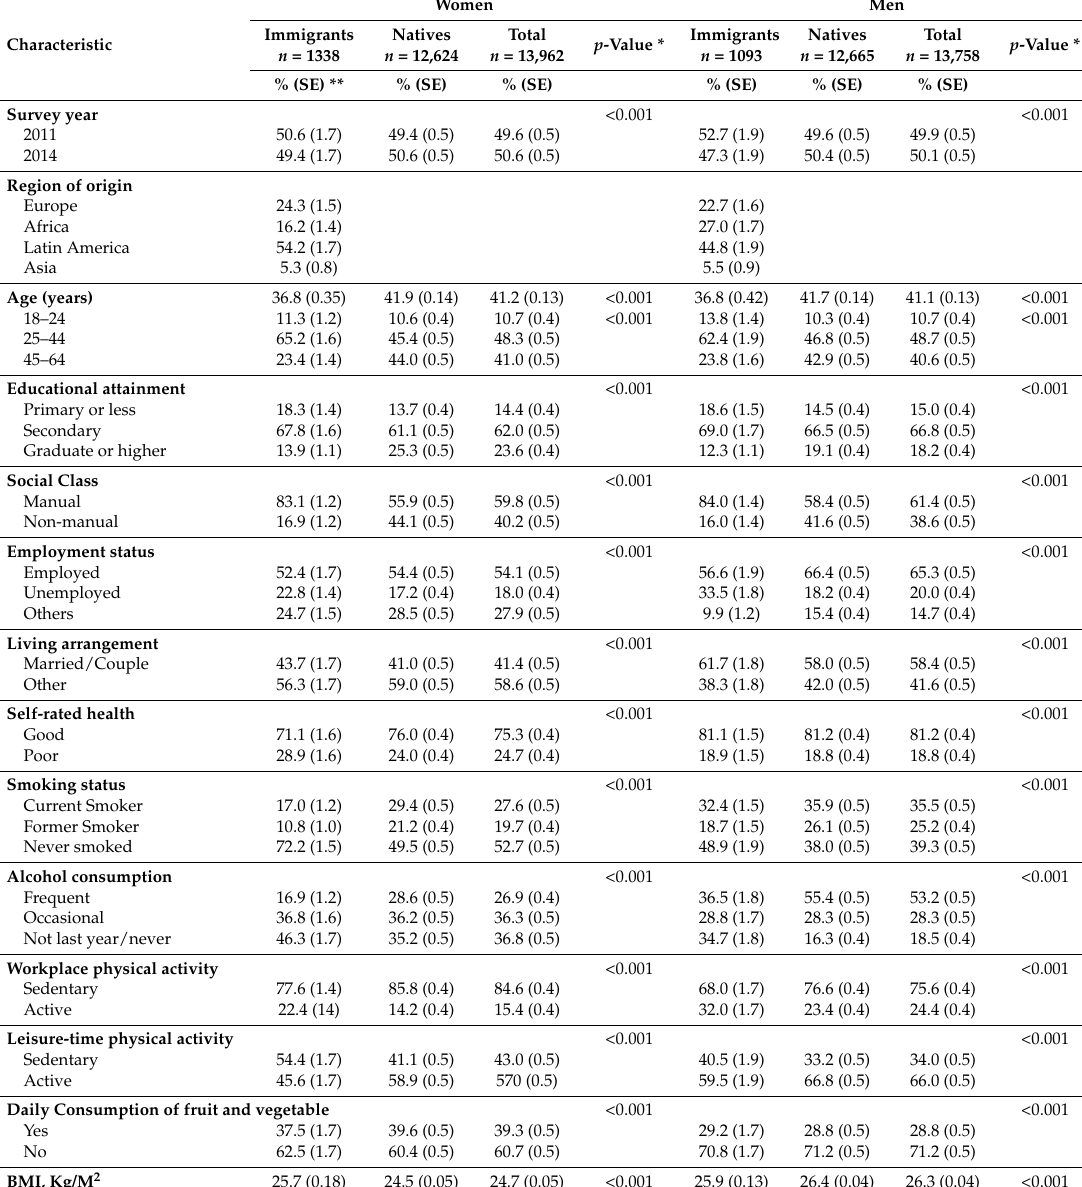
Table 1. Distribution of sociodemographic, self-rated health and health behavior characteristics for participants of the Spanish National Health Survey 2011–2012 and European Health Survey in Spain